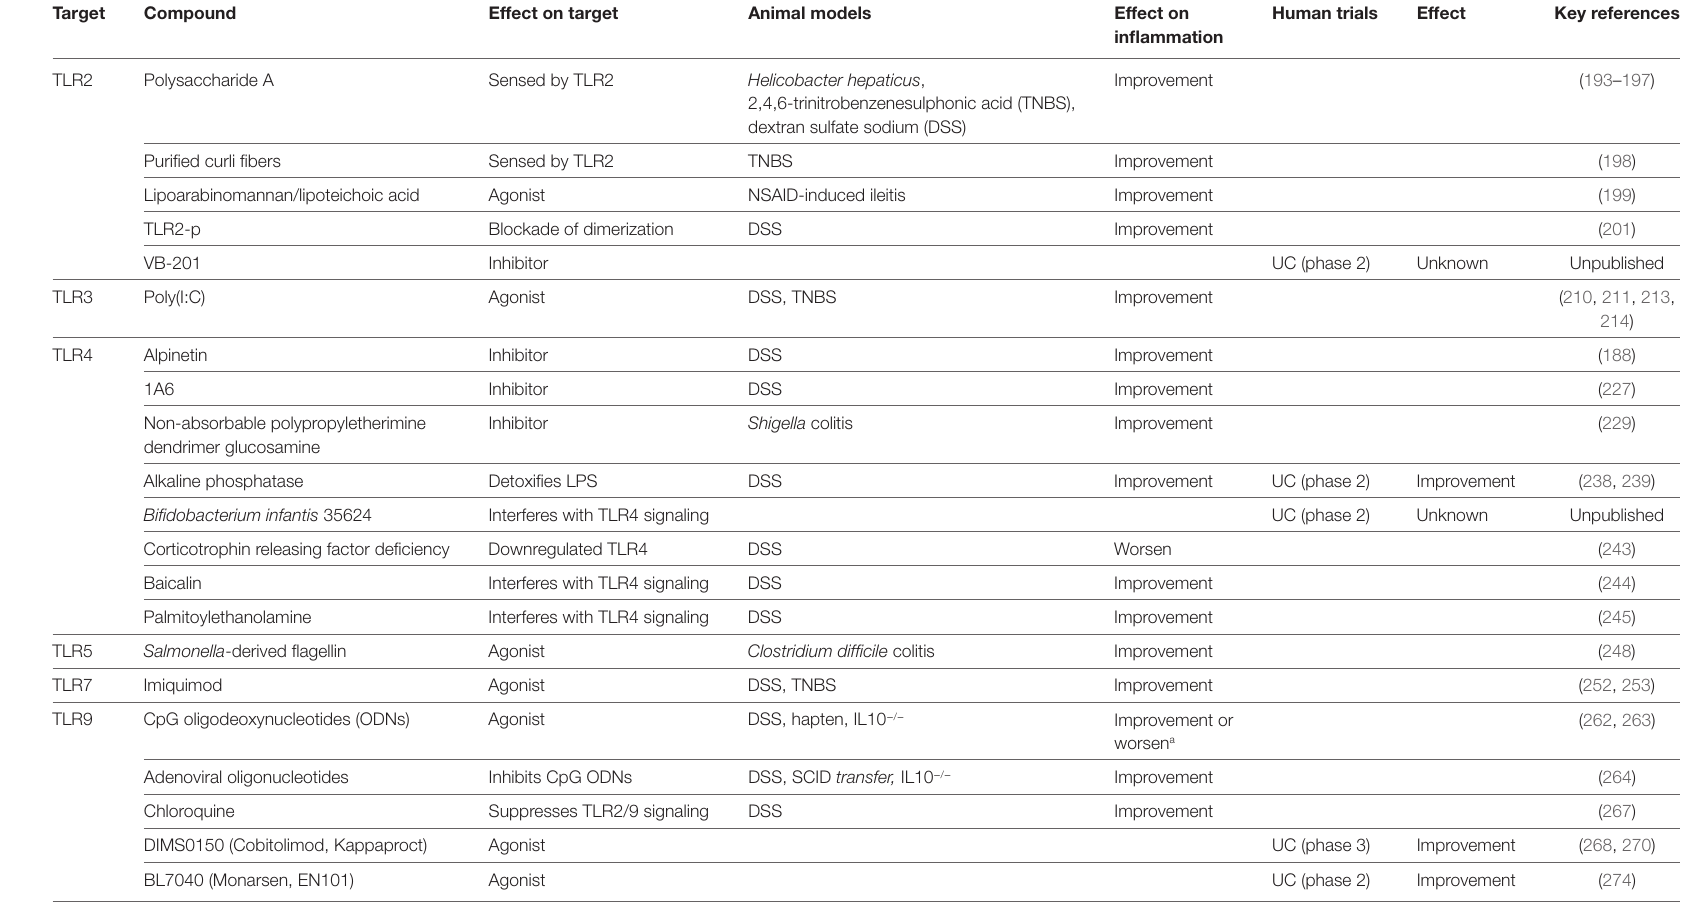
TABLe 1 | A summary of compounds targeting Toll-like receptors to modulate animal and/or human intestinal